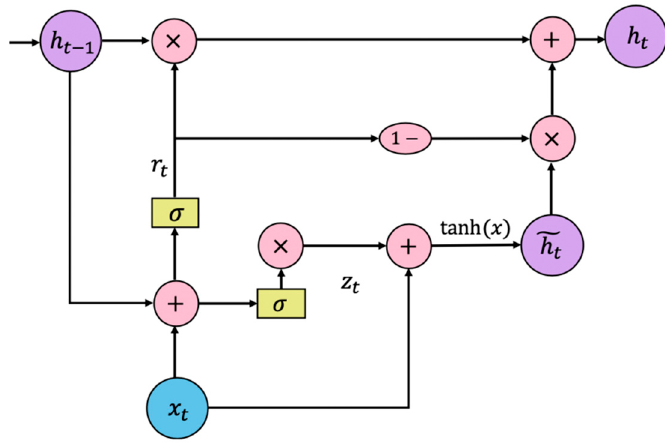
Figure 13. Schematic diagram of the GRU neural network hidden layer structure.